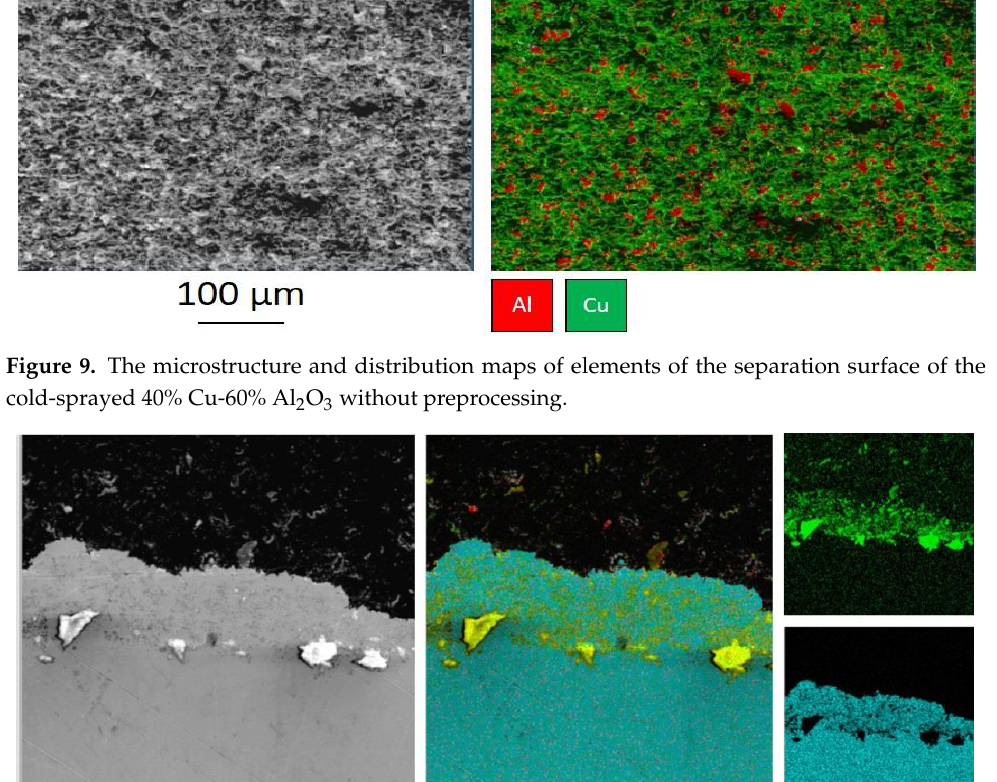
Figure 10. Microstructure and distribution maps of the elements of the substrate and the Cu-60% Al 2 O 3 coating remaining on it after the coating was tearing off from the substrate with preliminary treatment.